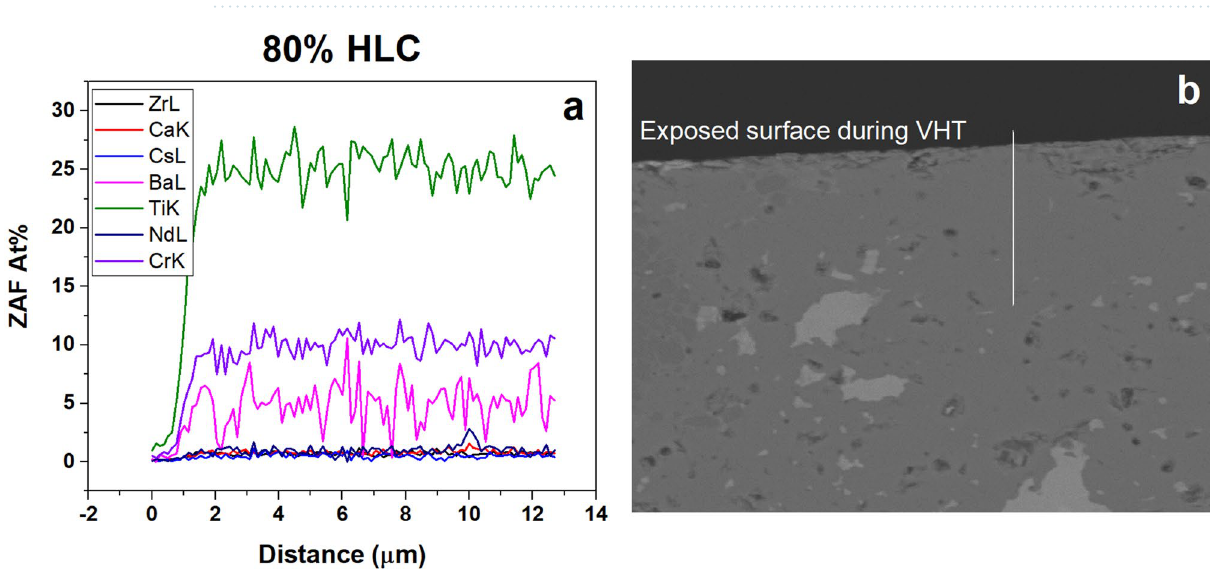
Figure 8. ( a ) SEM–EDS line scan results across the hollandite phase of the 80%-hollandite low Cs (HLC) designer waste form sample and ( b ) corresponding SEM